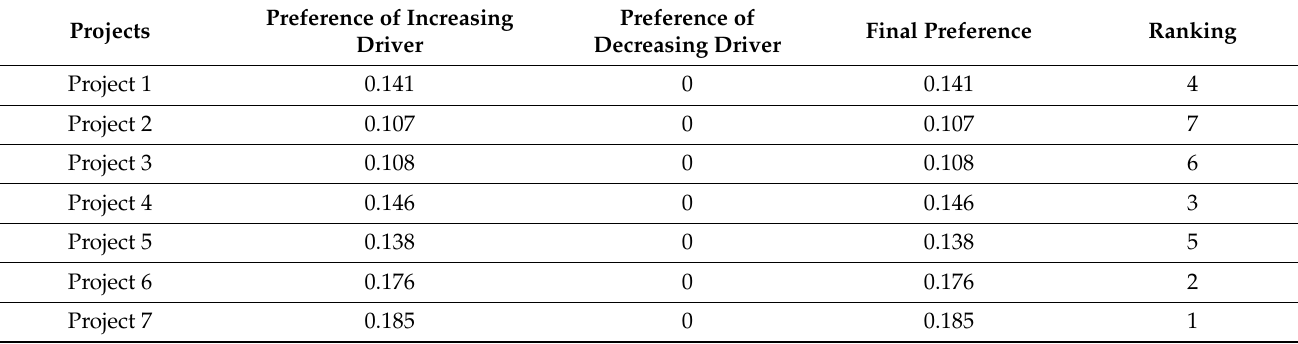
Table 9. Final preferences and ranking.